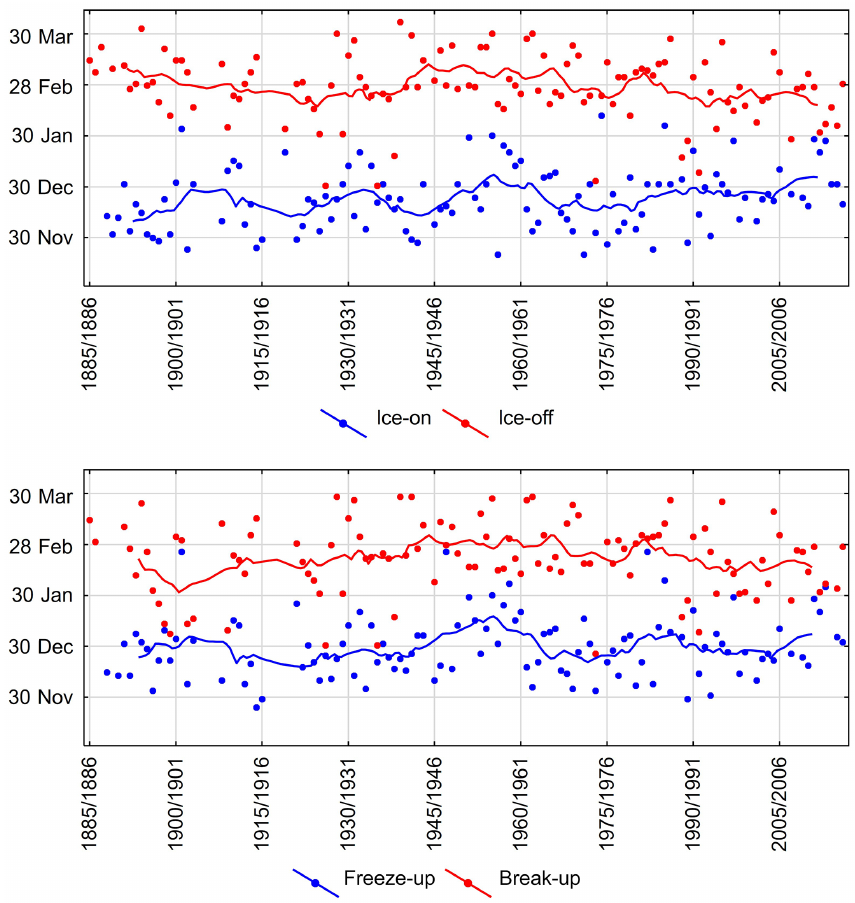
Figure 6. Variations of the dates of ice-on, freeze-up, break-up and ice-off on Lake Balaton from 1885 to 2017. (Blue and red curves are 10-year moving